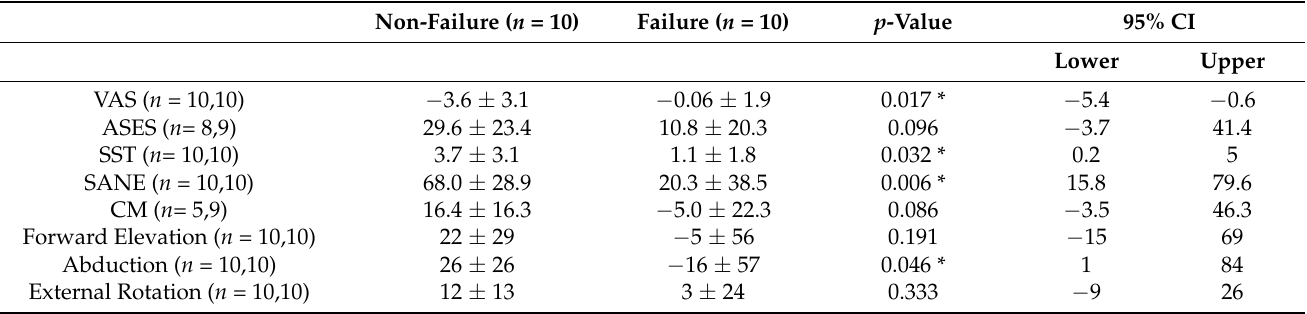
Table 3. Post-operative Change in Pain and Function